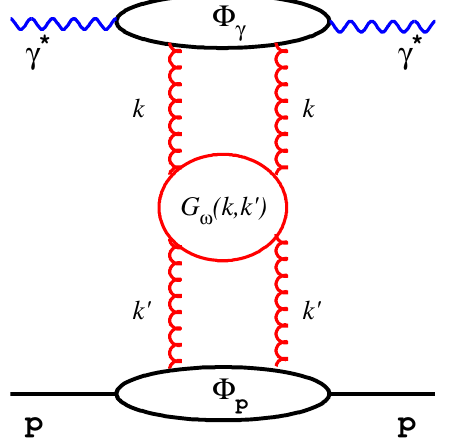
Fig. 1 Evaluation of F 2 in γ ∗ p scattering using the BFKL Green